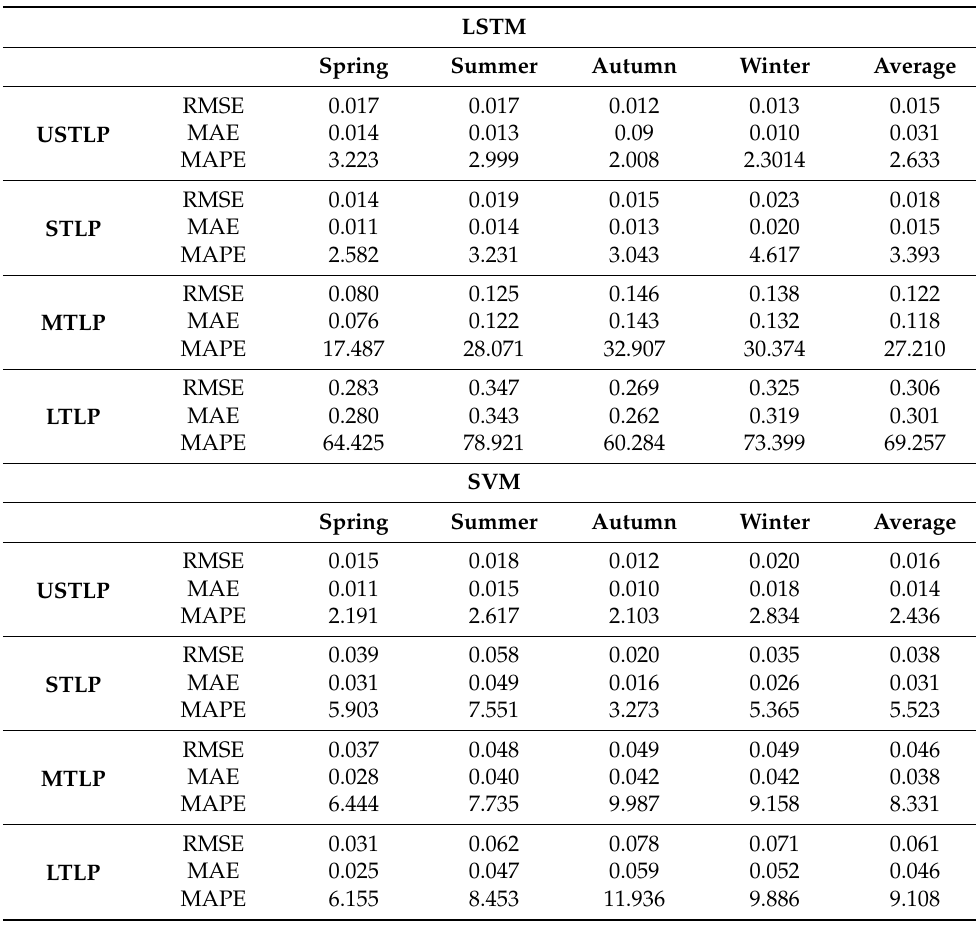
Table 4. Model metric for two algorithms in four seasons.